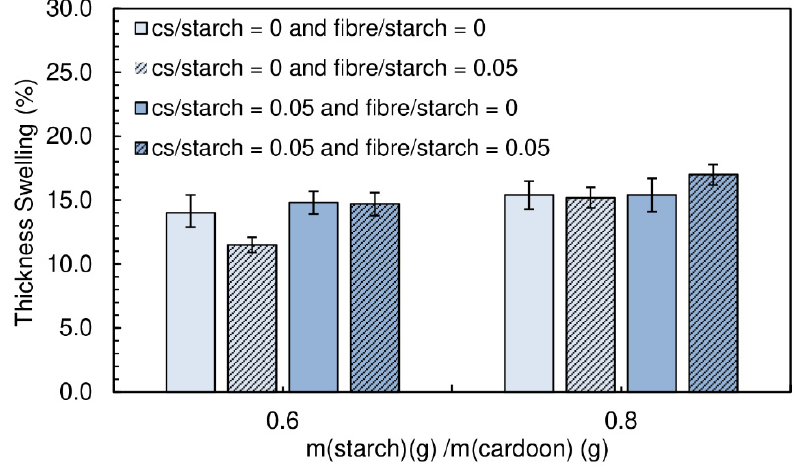
Figure 8. Effect of fiber content and the combined effect of chitosan and fiber on thickness swelling of the particleboards bonded with a potato starch. All adhesive formulations had a starch/cardoon ratio of 0.6 and 0.8.